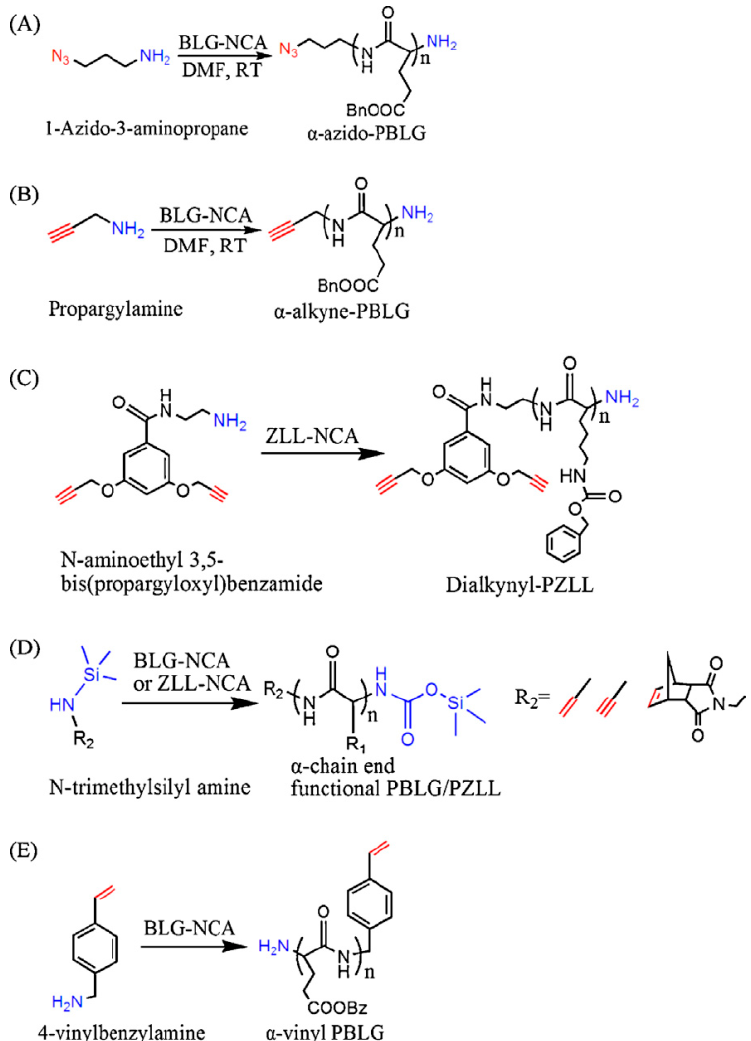
Figure 31. Synthesis of α -chain end functionalized polypeptides from initiators containing azido groups ( A ), alkyne groups ( B – D ), or alkene groups ( D , E ). Reproduced with permission from reference [31].